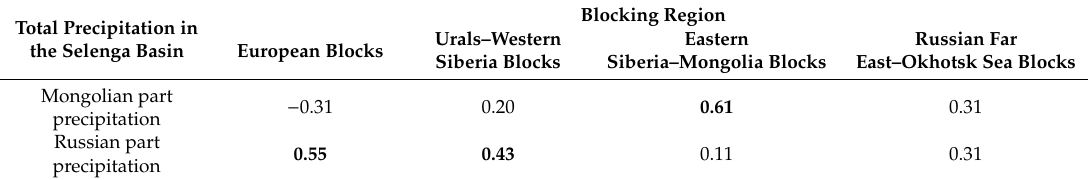
Table 1. The coe ffi cients of correlation of blocking frequency and precipitation in the Selenga Basin for the period 1979–1995; bold font indicates the significant coe ffi cient at 95% confidence